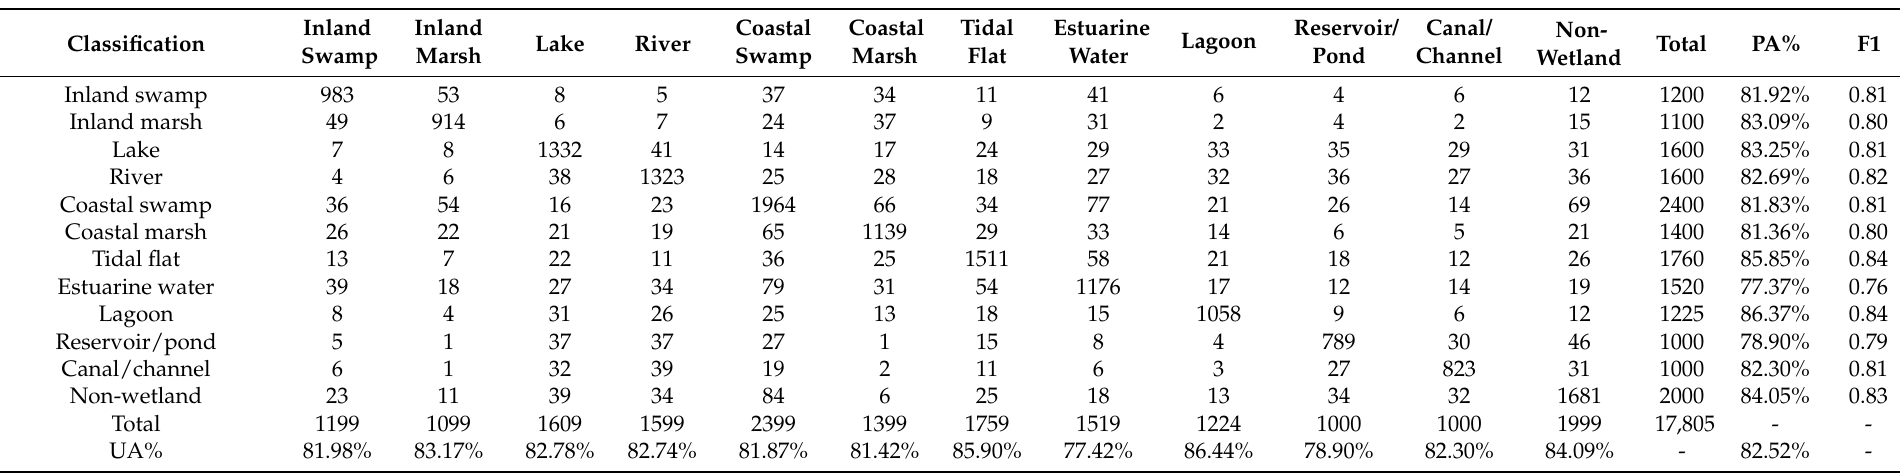
Table 3. The mapping accuracy of the